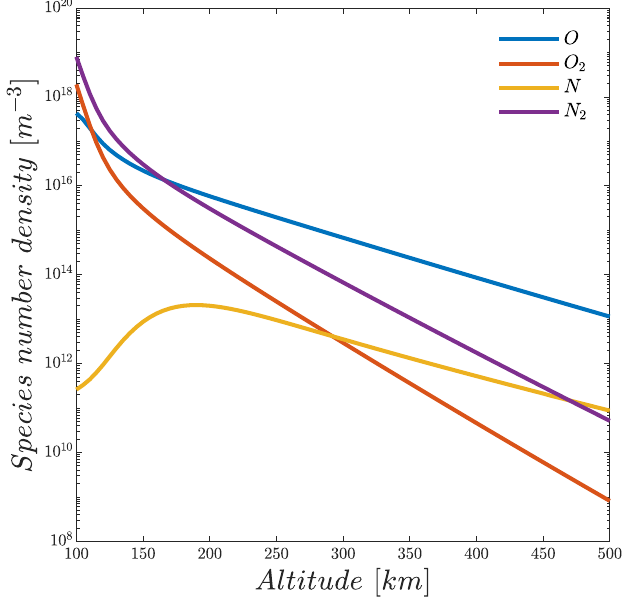
Figure 2. Atmospheric species’ number density as a function of the orbit altitude (latitude = 38.91 ◦ and longitude = 77.04 ◦ ), NRLMSISE-00 atmospheric model: F10.7, Ap = 15, moderate solar activ- ity